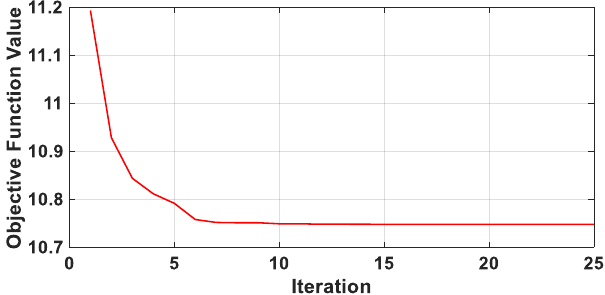
Figure 7. Convergence curve of objective function using SOS (symbiotic organisms search).